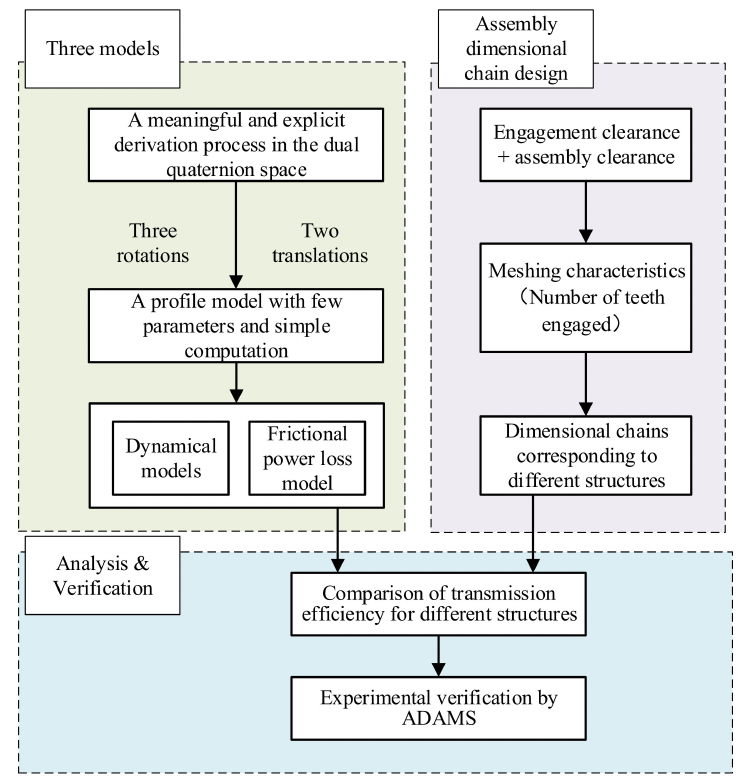
Figure 1. Thesis research framework.